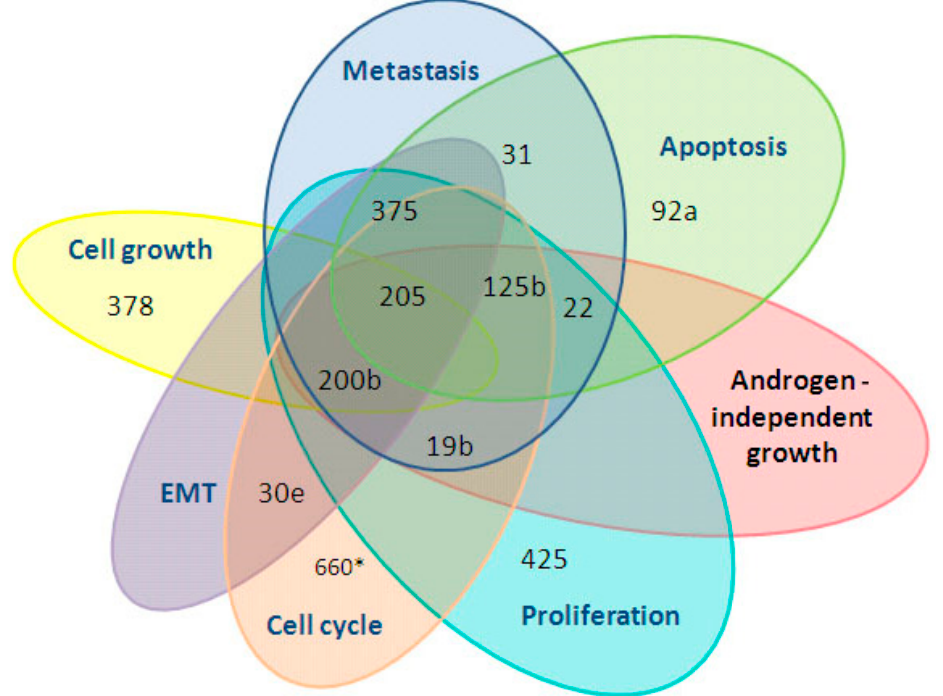
Figure 3. Involvement of the 12 cell-free miRNAs in tumor-related processes. The research papers were available in PubMed and were found by searching the following keywords: prostate, cancer,